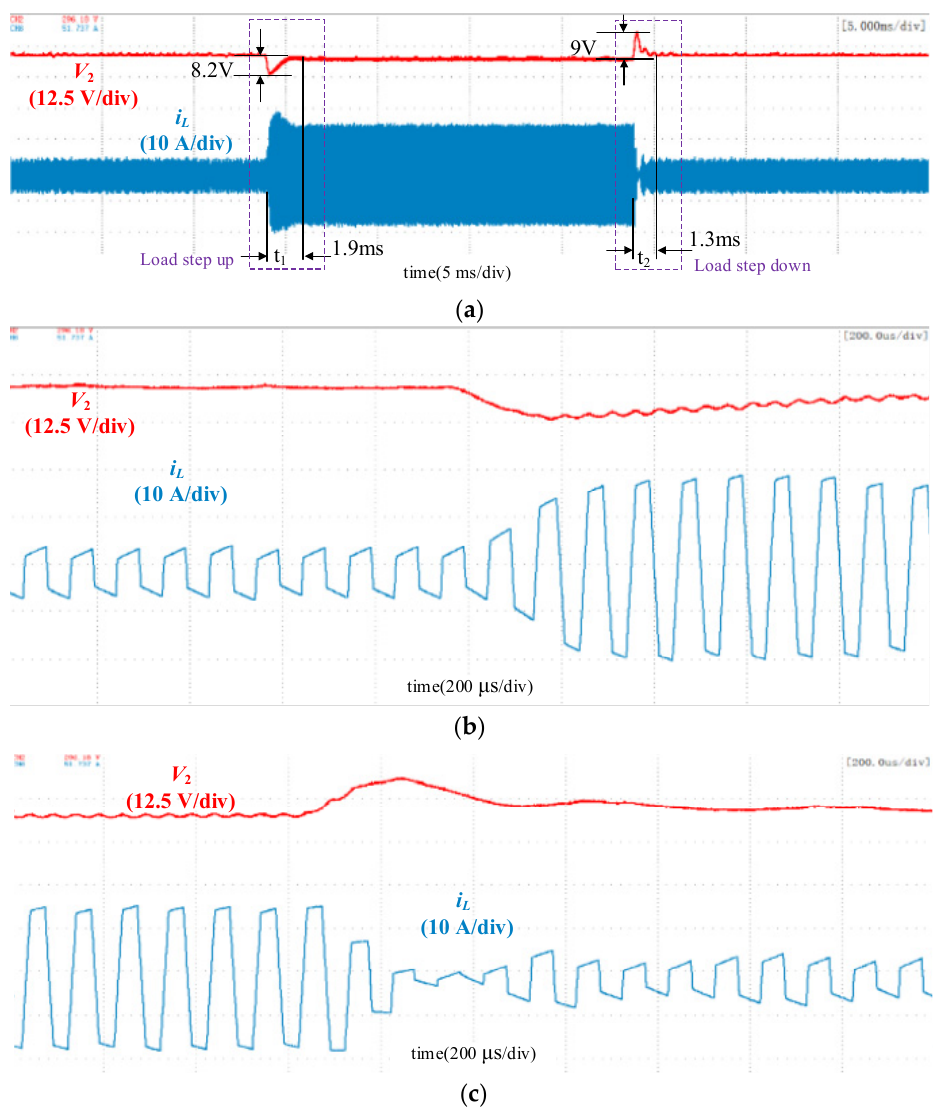
Figure 11. Waveforms using the double-closed-loop control. ( a ) Overall waveforms; ( b ) Zoomed-in waveforms during the load increase; ( c ) Zoomed-in waveforms during the load decrease.